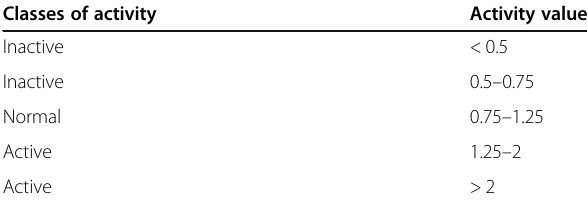
Table 1 Activity values in soil materials (Skempton